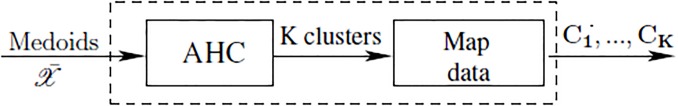
The second stage of MAHC algorithm.